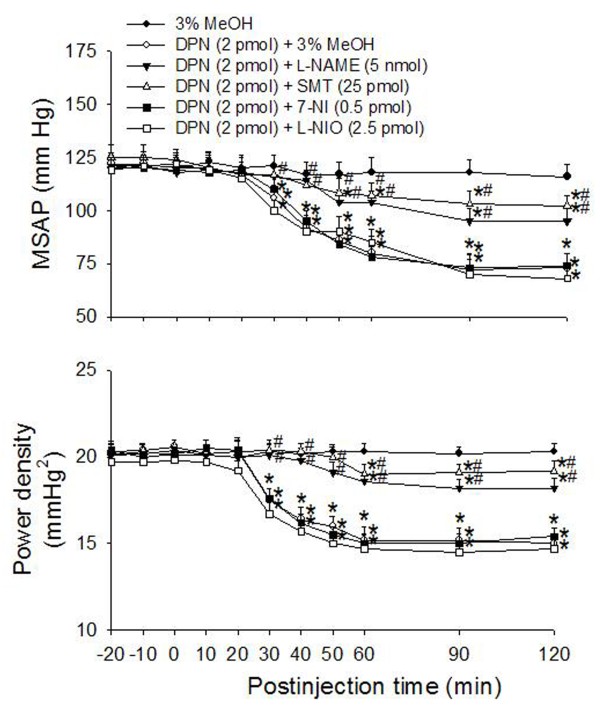
Effects of NOS inhibitor on the ERβ agonist-induced cardiovascular depressive effects. Time-course of the changes in MSAP and total power density of vasomotor components (0–0.8 Hz) of SAP spectrum in anaesthetized rats that received microinjection bilaterally into the RVLM (at time 0) of aCSF, 3% methanol (MeOH), or DPN (2 pmol) given together with L-NAME (5 nmol), SMT (25 pmol), 7-NI (0.5 pmol), L-NIO (2.5 pmol) or 3% MeOH. Values are mean ± S.E.M., n = 6–7 animals per experimental group. *P < 0.05 versus corresponding MeOH group, and #P < 0.05 versus corresponding DPN+MeOH group in the Scheffé multiple range test. Data on aCSF are not shown because they in essence duplicated those by 3% MeOH.